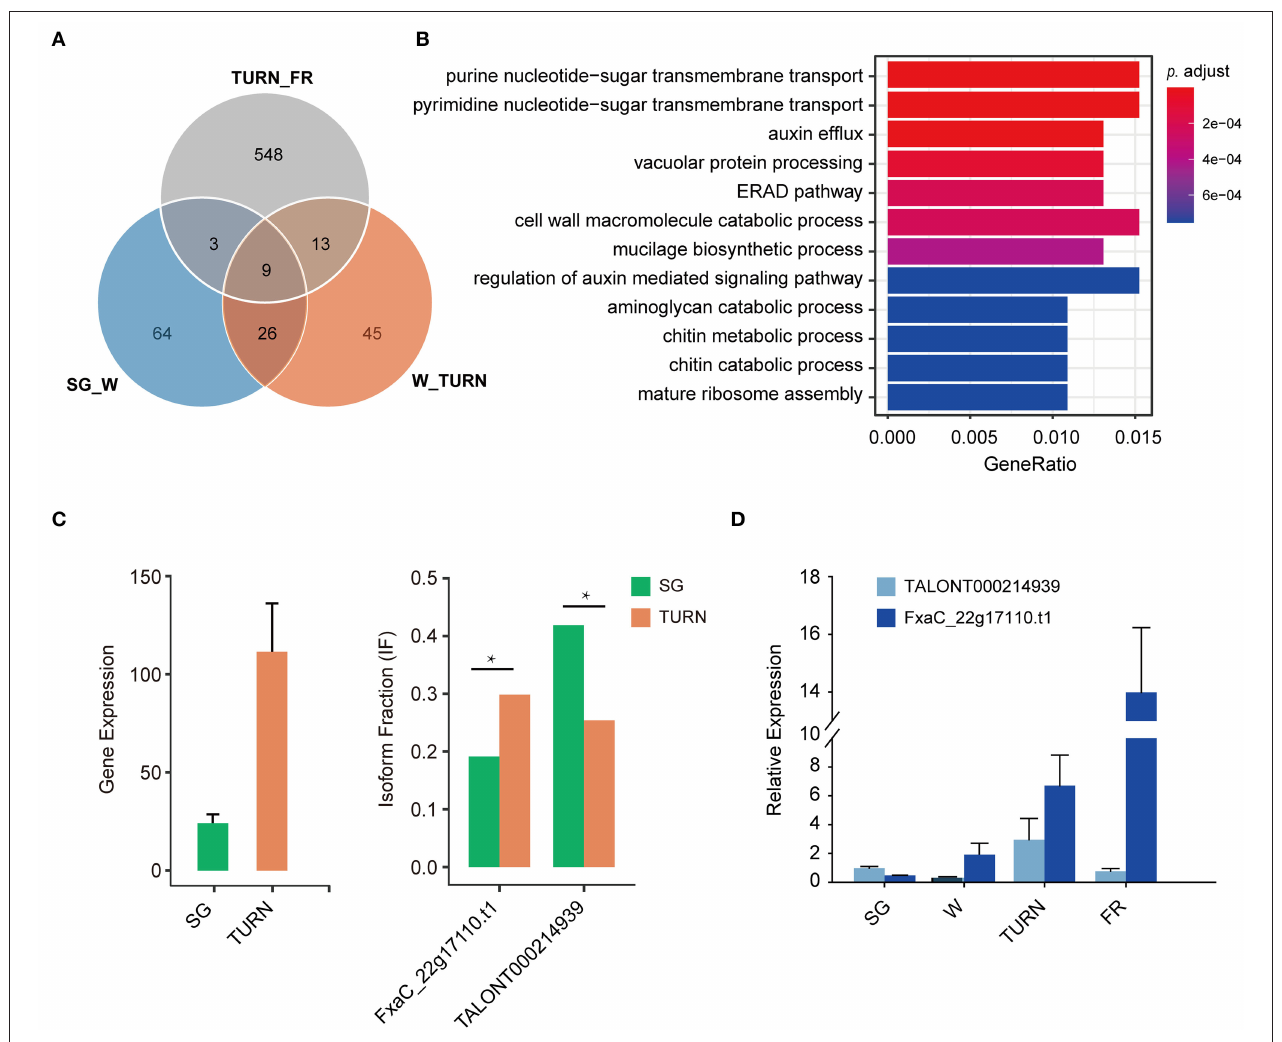
FIGURE 5 | The number of genes with isoform switch events and the enriched GO terms of these genes. (A) Isoform switch events detected in the adjacent fruit developmental stages, (B) the corresponding enriched GO term associated with the switching genes in the comparison of TURN vs. FR, (C) an example of isoform usage alternation between the two representative isoforms of the gene FxaC_22g17110, and (D) RT-qPCR validation of the expression level of these two transcripts in strawberry fruits at four developmental stages. SG, small green; W, white fruit; TURN, turning stage; FR, full red stage. Significance levels were estimated by two-sided Fisher exact tests, * indicated FDR corrected p <